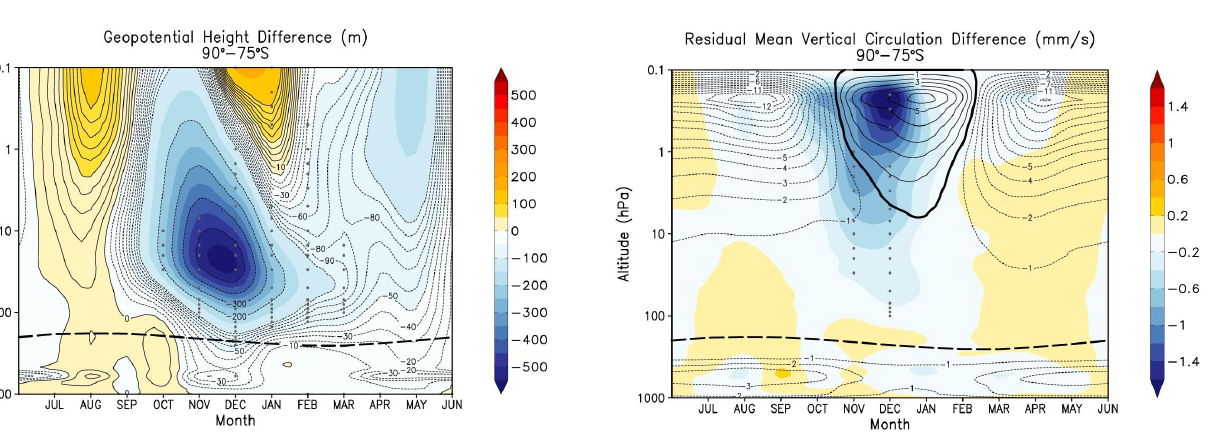
Figure 5: Zonal mean, monthly mean geopotential height difference between REF2000 and Figure 6: Zonal mean, monthly mean residual vertical velocity, 𝑤̅ ∗ , REF2000 climatology Figure 5. Zonal mean, monthly mean geopotential height difference Figure 6. Zonal mean, monthly mean residual vertical velocity, w ∗ , between REF2000 and NHC, averaged over 90–75 ◦ S. Shaded con- NHC, averaged over 90°-75°S. Shaded contour intervals are 50 m, while contour lines are REF2000 climatology (contours) and difference between REF2000 (contours) and difference between REF2000 and NHC (shaded) averaged over 90°-75°S. tour intervals are 50m, while contour lines are every 10m between and NHC (shaded) averaged over 90–75 ◦ S. Contour intervals are every 10 m between 100 and -100 m and 100 m outside of this range. Solid/dashed contours Contour intervals are 1 mm s -1 , solid/dashed contours represent upwelling/downwelling 100 and − 100m and 100m outside of this range. Solid/dashed con- 1mms − 1 , solid/dashed contours represent upwelling/downwelling represent positive/negative changes. Stippling denotes significance at the 95% confidence respectively. The 0 mm s -1 contour is highlighted in bold. Stippling denotes significance at tours represent positive/negative changes. Stippling denotes signif- respectively. The 0mms − 1 contour is highlighted in bold. Stippling level. The bold dashed line signifies the tropopause height in the REF2000 simulation. the 95% confidence level. The bold dashed line signifies the tropopause height in the icance at the 95% confidence level. The bold dashed line signifies denotes significance at the 95% confidence level. The bold dashed the tropopause height in the REF2000 simulation. REF2000 simulation. line signifies the tropopause height in the REF2000